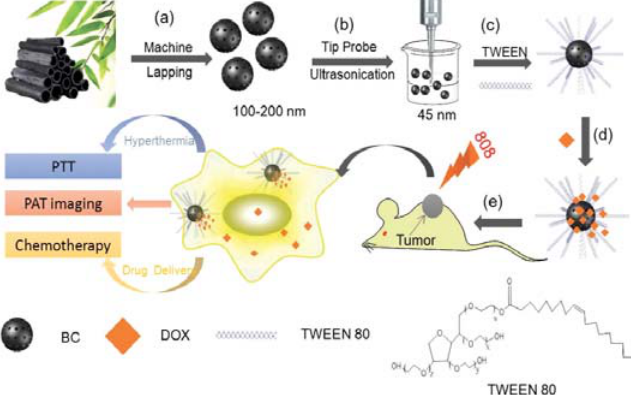
Figure 5 . Schematic illustration of ( a , b ) experimental design for the synthesis of BCNPs; ( c , d ) BCNPs functionalized with TWEEN 80 for DOX loading; ( e ) BCNPs as a novel theranostic platform for PAT imaging-guided 808 nm NIR-laser-stimuli-responsive chemo-photothermal therapy of tumor. BCNP = bamboo charcoal nanoparticle. Reproduced with permission from [85]. Wiley,